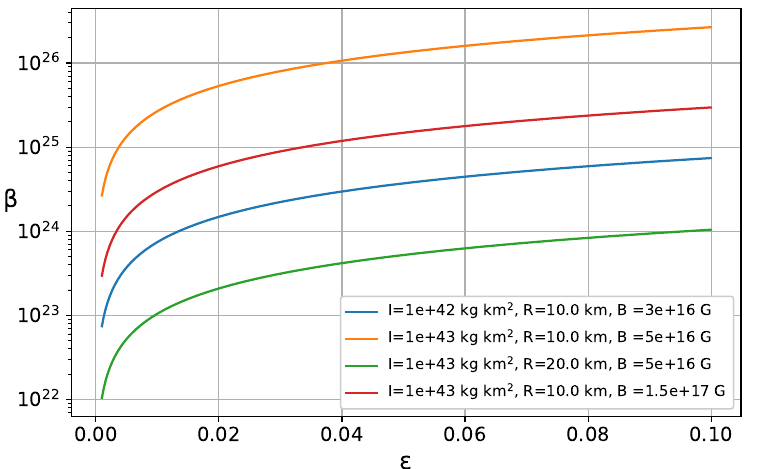
Figure 1. Expected evolution of the dimensionless parameter ( β ) with ellipticity ( (cid:101) ) for the free parameters radius ( R ) , magnetic field ( B ) , and moment of inertia ( I ) . The parametric valuesare exhibited in the